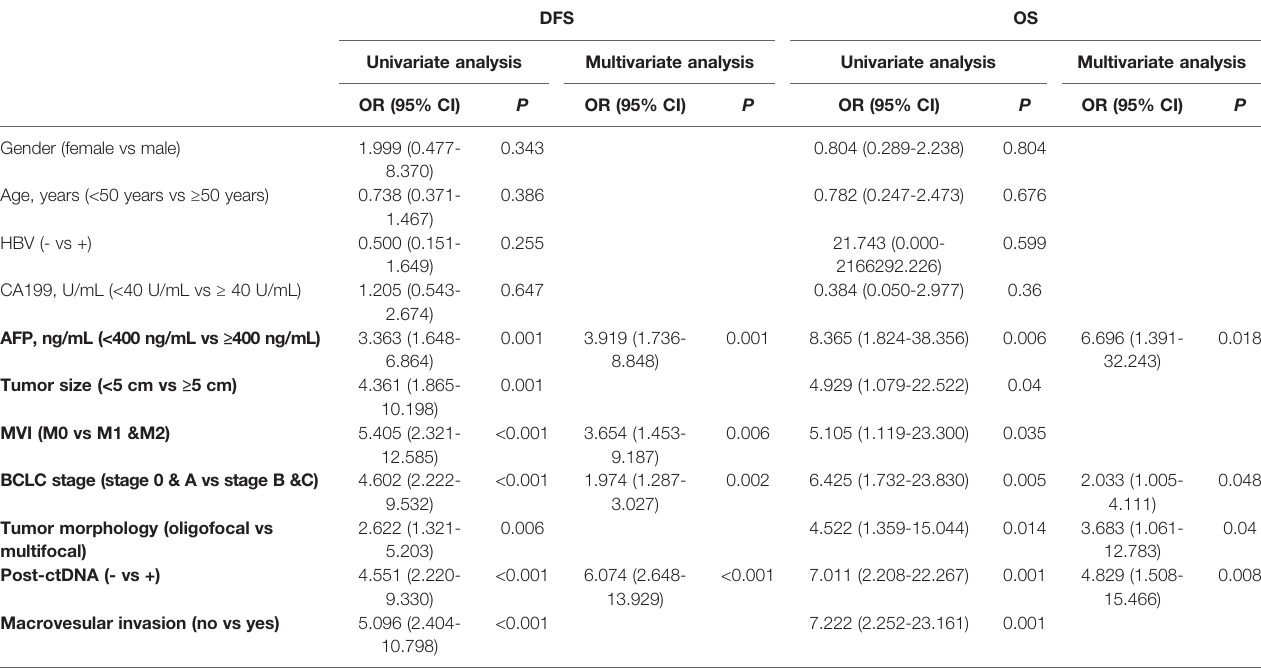
TABLE 3 | Univariate and Multivariate analysis of prognostic